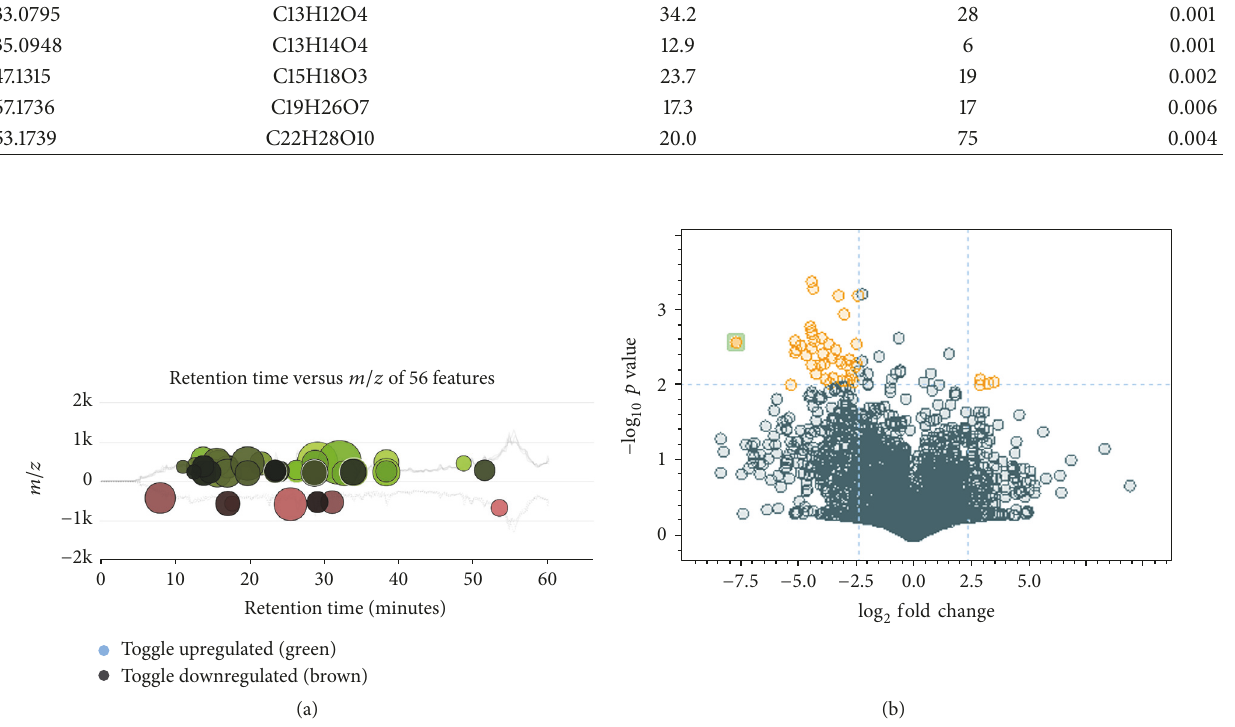
Figure 3: Analyses performed on LC-MS data for generation of precursors list: (a) cloud plot obtained by XCMS with the following settings: intensity > 5 ⋅ 10 4 ; fold change ≥ 5; 𝑝 ≤ 0.01 . (b) Volcano graph obtained by ProfileAnalysis with the following settings: fold change ≥ 5; 𝑝 ≤ 0.01 .